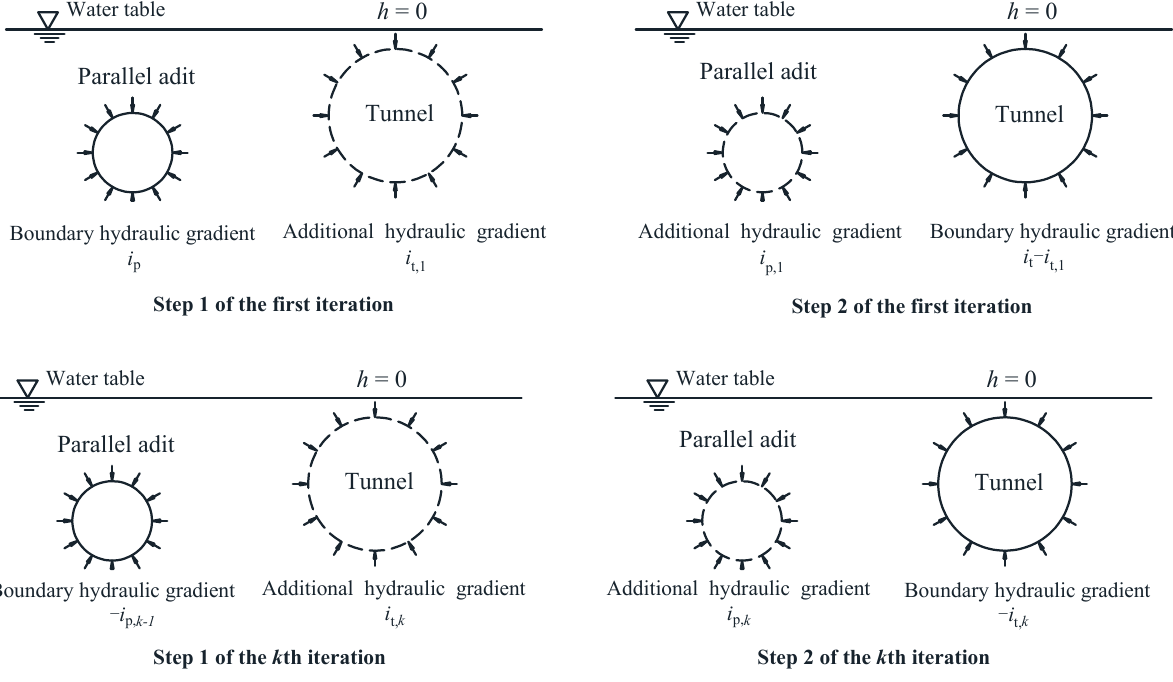
Figure 5. Boundary conditions in alternating iterations.